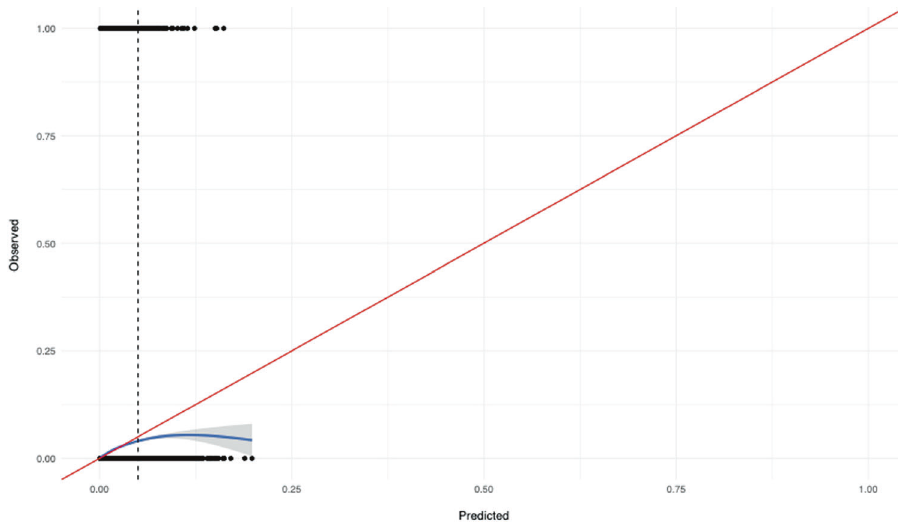
Fig. 2 Calibration plot comparing predicted and observed risks of suicide in the Finnish external validation sample of individuals with severe mental illness ( n = 137,112). Note: The dashed vertical line denotes 5 percent predicted risk, which is the maximum cut-off value presently used in the OxMIS online